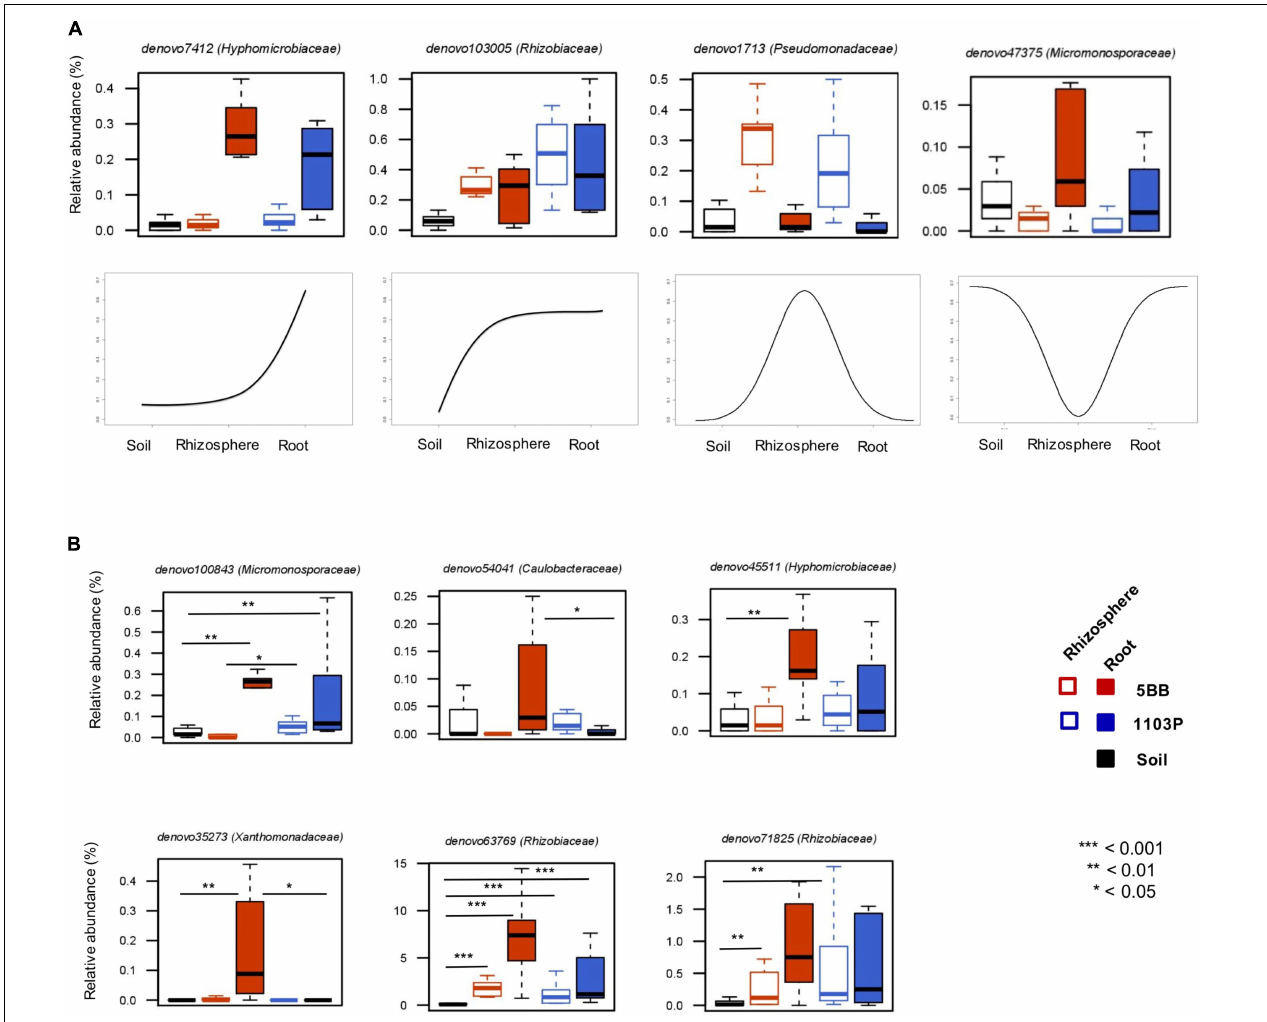
FIGURE 5 | Dynamic plots based on the relative abundance of OTUs with different preference for soil, rhizosphere, and root compartments of V. vinifera cultivar Lambrusco grafted onto different rootstocks. (A) Examples of OTU niche differentiation across the three microhabitats. (B) Differences between the two groups of plants (grafted on the 5BB or 1103P rootstock) in terms of OTU niche preference. P -values were assessed by Mann-Whitney-Wilcoxon test. See also Supplementary Table S2